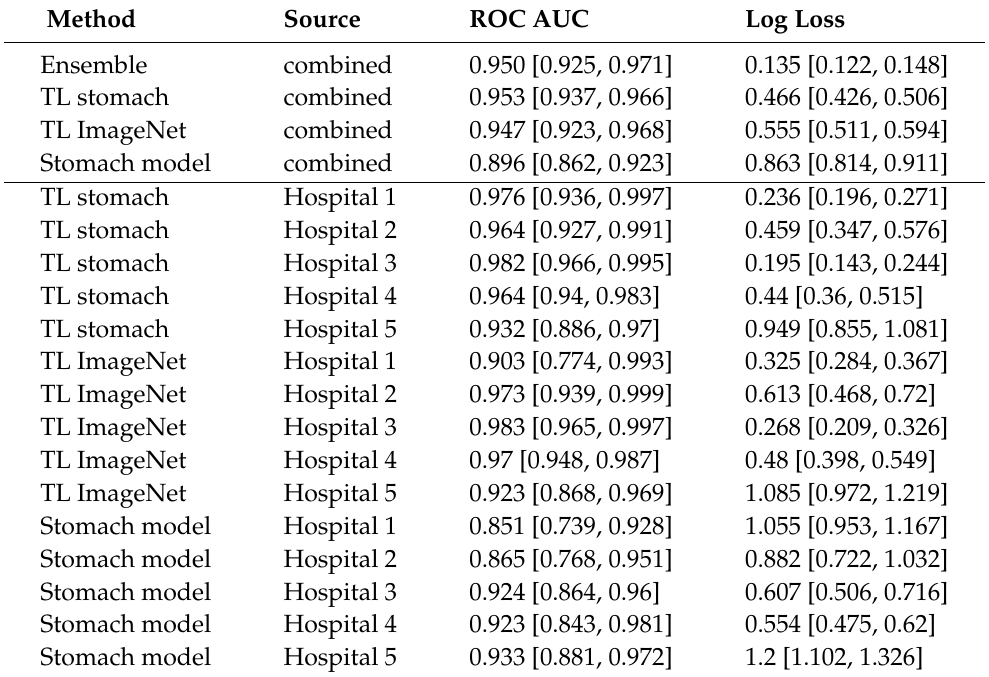
Table 2. ROC and log loss results on the different test sets using the different transfer learning methods.